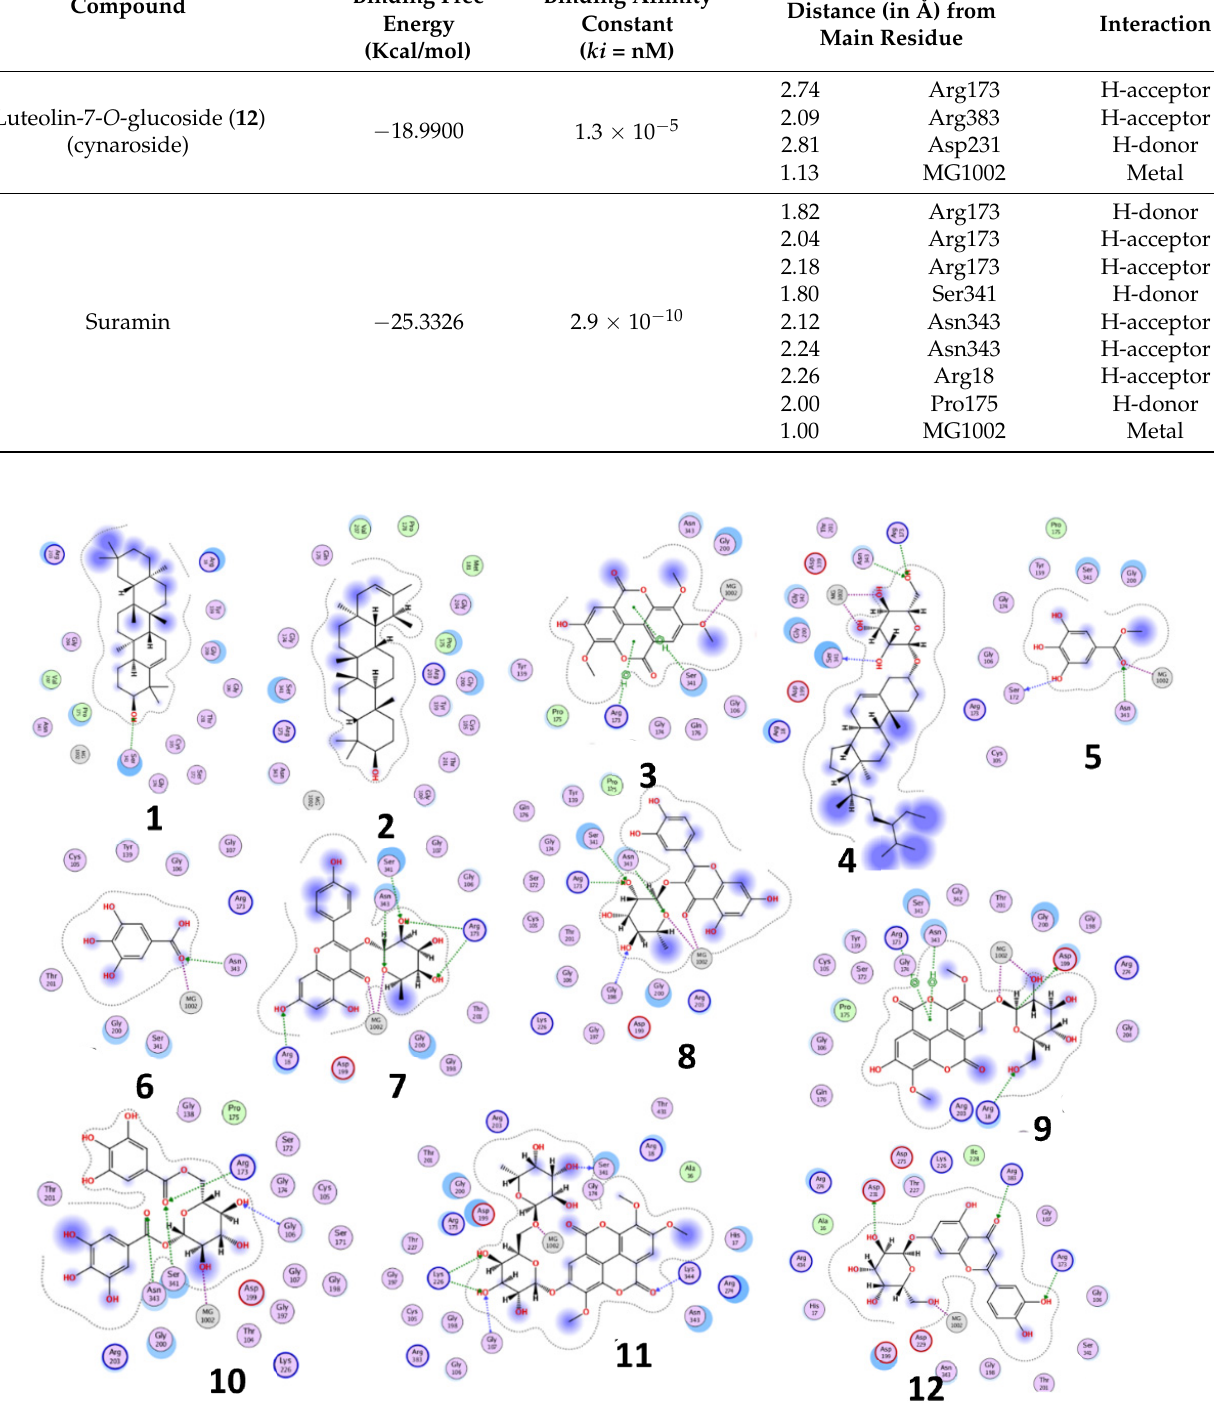
Figure 2. 2D interaction diagram of the top docking pose of the isolated compounds.